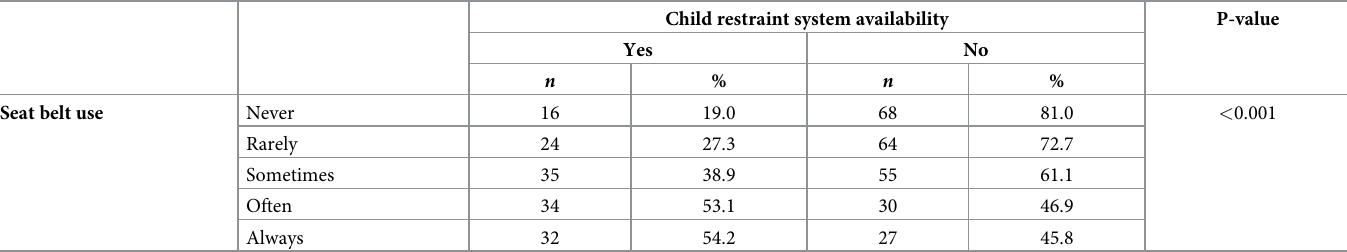
Table 3. Association between seat belt use and child restraint system availability.